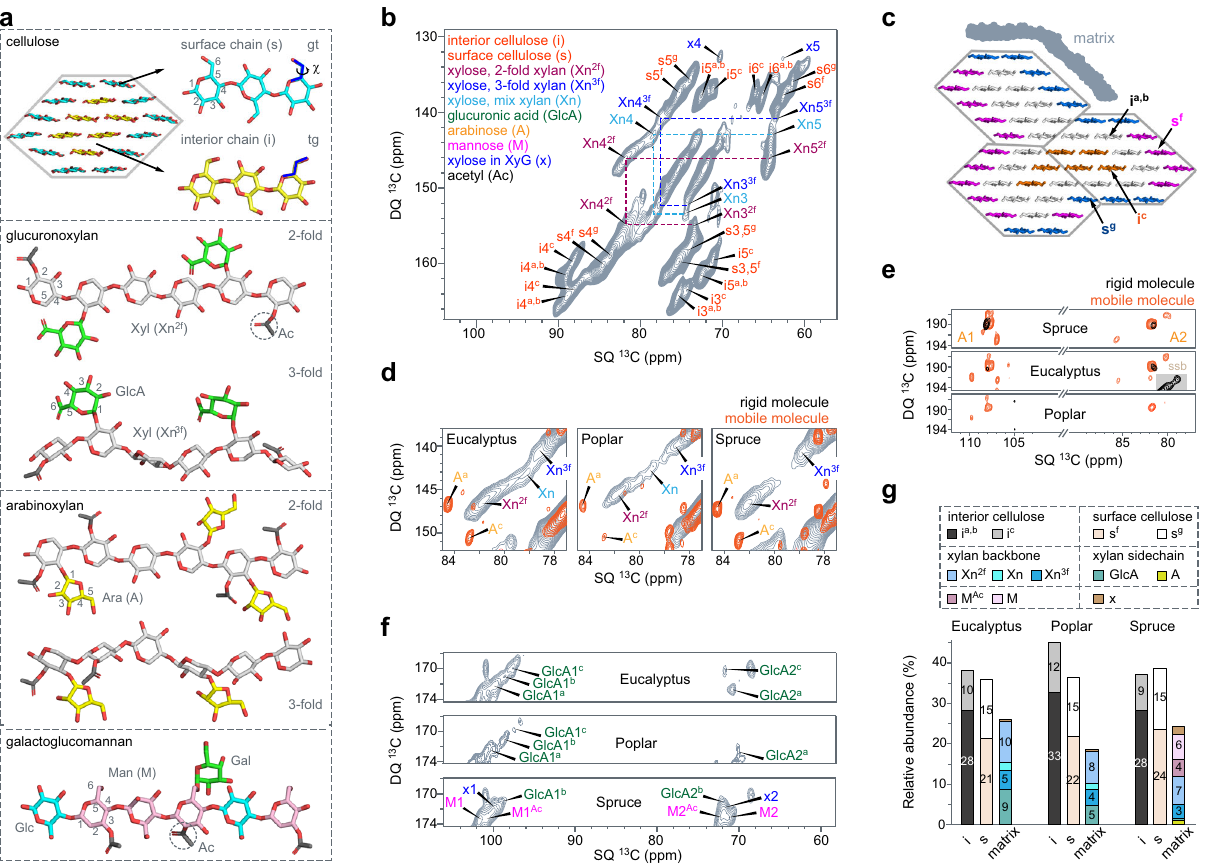
Fig. 1 Solid-state NMR resolves the polymorphic structure of polysaccharides using intact wood cells. a Representative structures of cellulose and major types of hemicellulose (xylan and galactoglucomannan). The cross-section of an elementary cellulose micro fi bril is shown, with a close view of an individual glucan chain and the hydroxymethyl conformation of surface (gauche-trans, gt) and internal (trans-gauche, tg) glucan chains. Xylan has two-fold or three-fold helical screw conformation in the backbone (Xn 2 f and Xn 3 f ), with glucuronic acid (GlcA) or arabinose (Ara or A) sidechains. Acetyl motifs (Ac) are present in hemicelluloses. b Representative 2D 13 C J-INADEQUATE spectrum of eucalyptus, which is based on 13 C cross polarization selecting rigid molecules. Dash lines track the carbon connectivity of xylan conformers. The NMR abbreviations of the carbohydrates are given. c A model of three elementary cellulose micro fi brils fi tting the NMR observables. The hydrophilic (s f ) and hydrophobic (s g ) surfaces, the embedded chains (i c ), and the middle layer (i a,b ) are color-coded. d Carbon-4 regions measured using 13 C direct polarization (orange spectra selecting mobile molecules) and cross polarization (gray spectra selecting rigid molecules). Both two- and three-fold xylan backbones are rigid while arabinose is mobile. e Arabinose carbon-1 and carbon-2 regions. The only rigid arabinose is the terminal one in xylan sidechain. f Eucalyptus has a high content of GlcA and spruce is rich in acetylated or non- acetylated mannose (M Ac or M). g Composition of the rigid molecules in cell walls determined by peak volumes from 2D spectra. Source data are provided as a Source Data fi